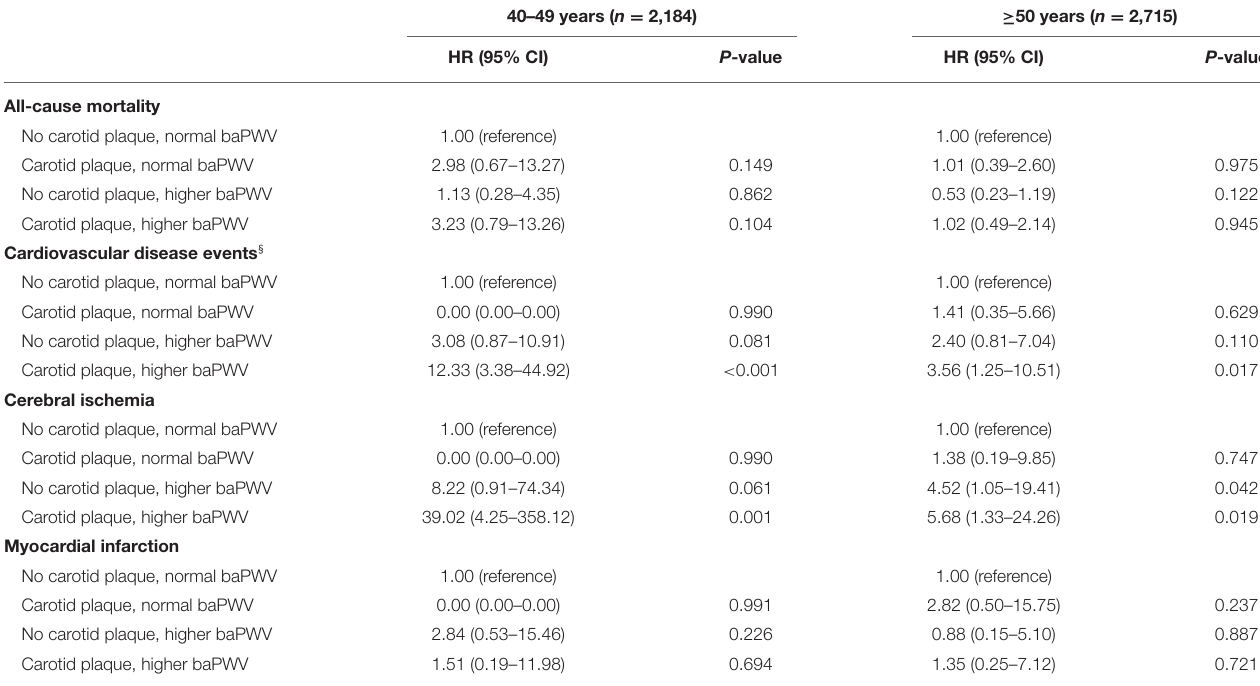
TABLE 3 | Association of carotid plaque and brachial-ankle pulse wave velocity status with all-cause mortality and cardiovascular disease events in subgroups stratified according to age *